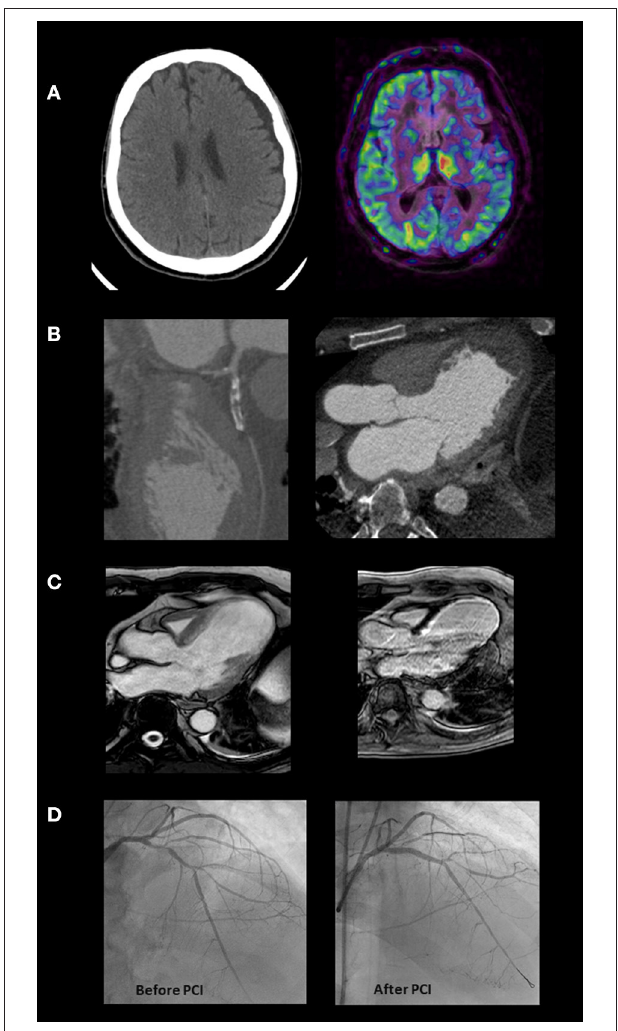
FIGURE 3 | This is the case of a 64-year-old man admitted to the emergency department with symptoms of nausea and vomiting. He reported onset of chest pain and dyspnea 10 days before, during the COVID-19 lock-down. The ECG showed signs of an evolving anterior STEMI. The skull CT (A) evidenced limited left ischemic stroke and large left hygromatous flap. The CCTA (B) demonstrates an occluded proximal left anterior descending (LAD) coronary artery, a large apical aneurysm of the left ventricle and an apical thrombus. Considering the bleeding risk associated with dual antiplatelet therapy and heparin and the need to better define residual viability, invasive coronary angiography (ICA) was deferred starting oral anticoagulation. Apical thrombus was no more evident at cardiac MRI, performed 3 weeks later (C) . The exam showed a severe left ventricular dysfunction (LVEF 28%), and an extensive but not transmural scar in the territory supplied by the LAD. Based on this evidence, after 3 weeks more, the patient underwent ICA confirming LAD disease which was treated by PCI and drug eluting stenting (D) . Before hospital discharge the implantation of an ICD was planned but unfortunately a sudden cardiac death occurred soon